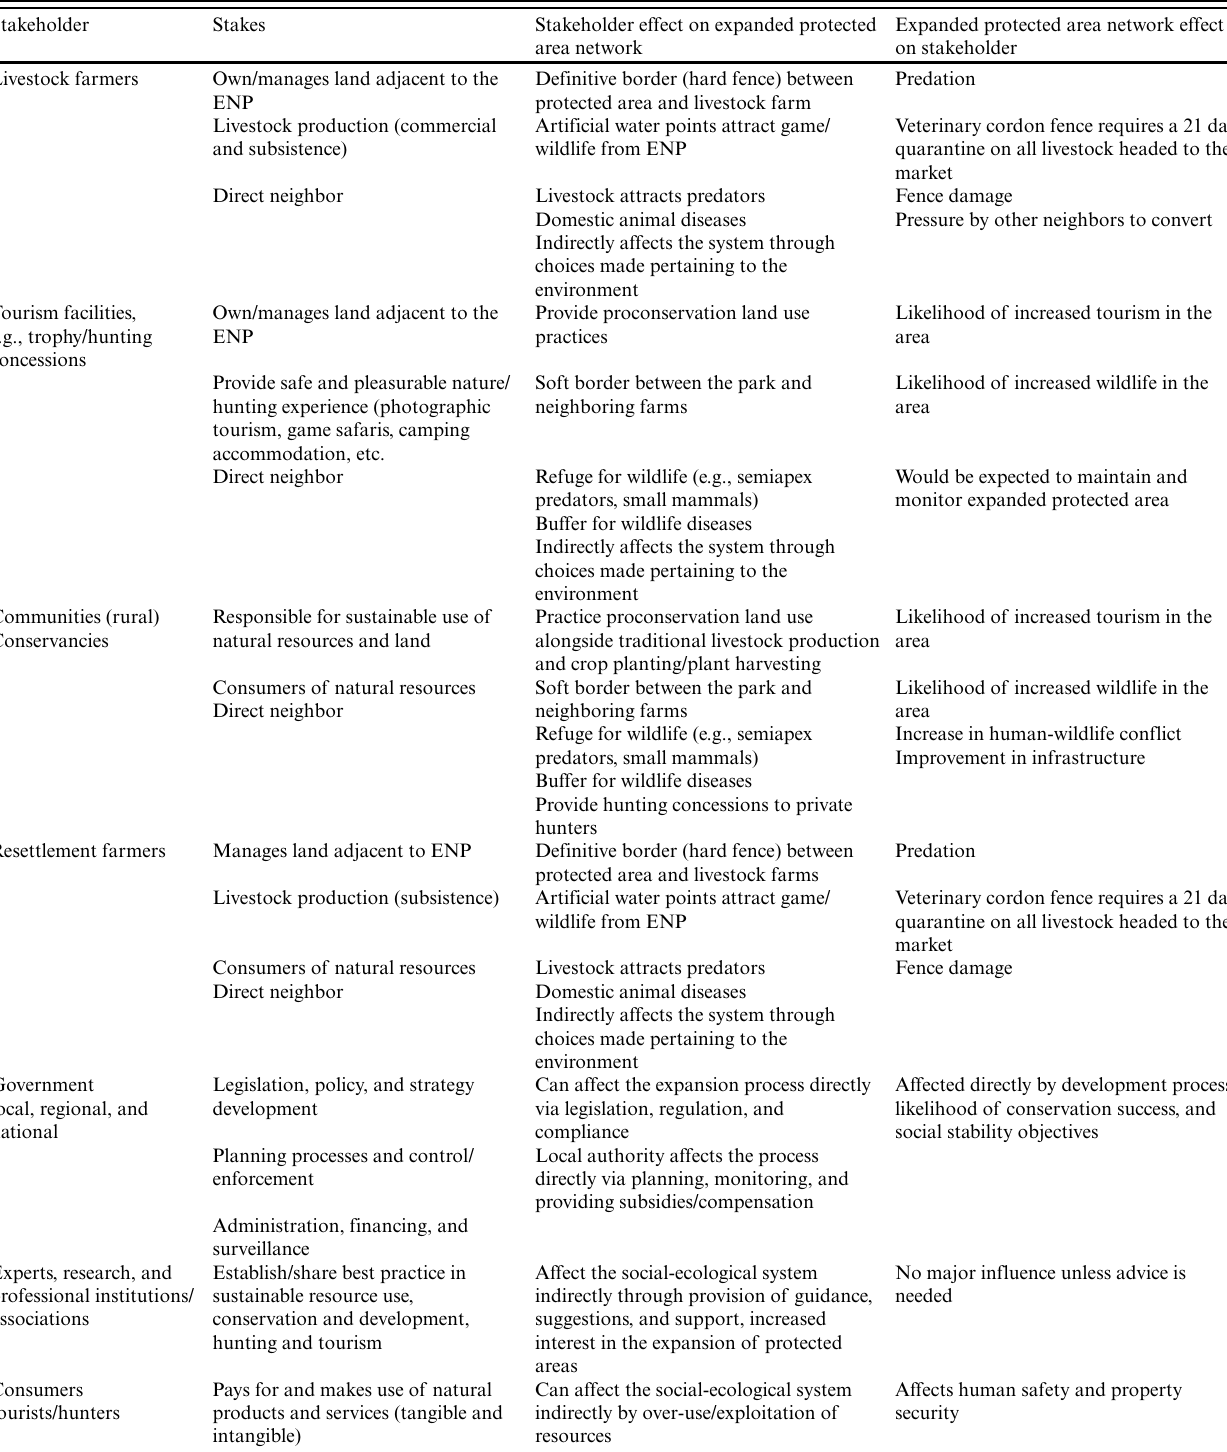
Table 3 . Stakeholder groups involved in the expansion of the protected area network around Etosha National Park (ENP).